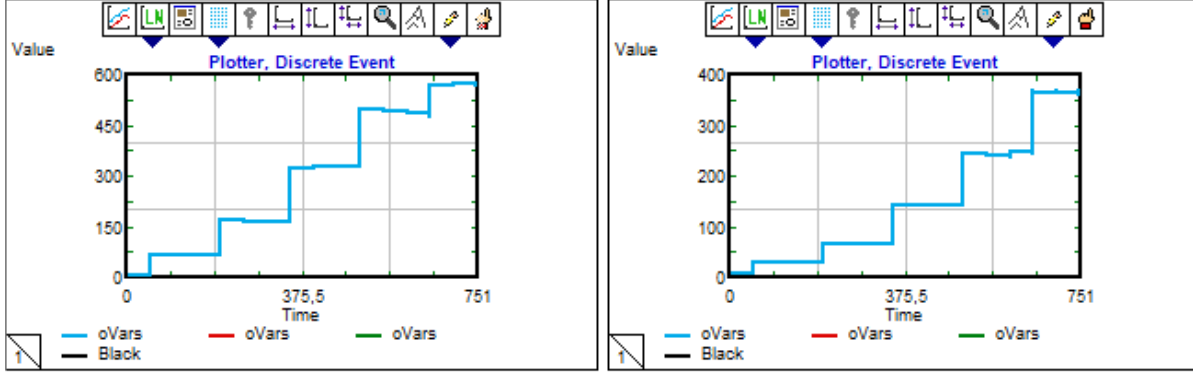
a graph, and the curve of this graph shows the progress of the simulation. Figure 4 presents the final graph with the significant change of the simulation